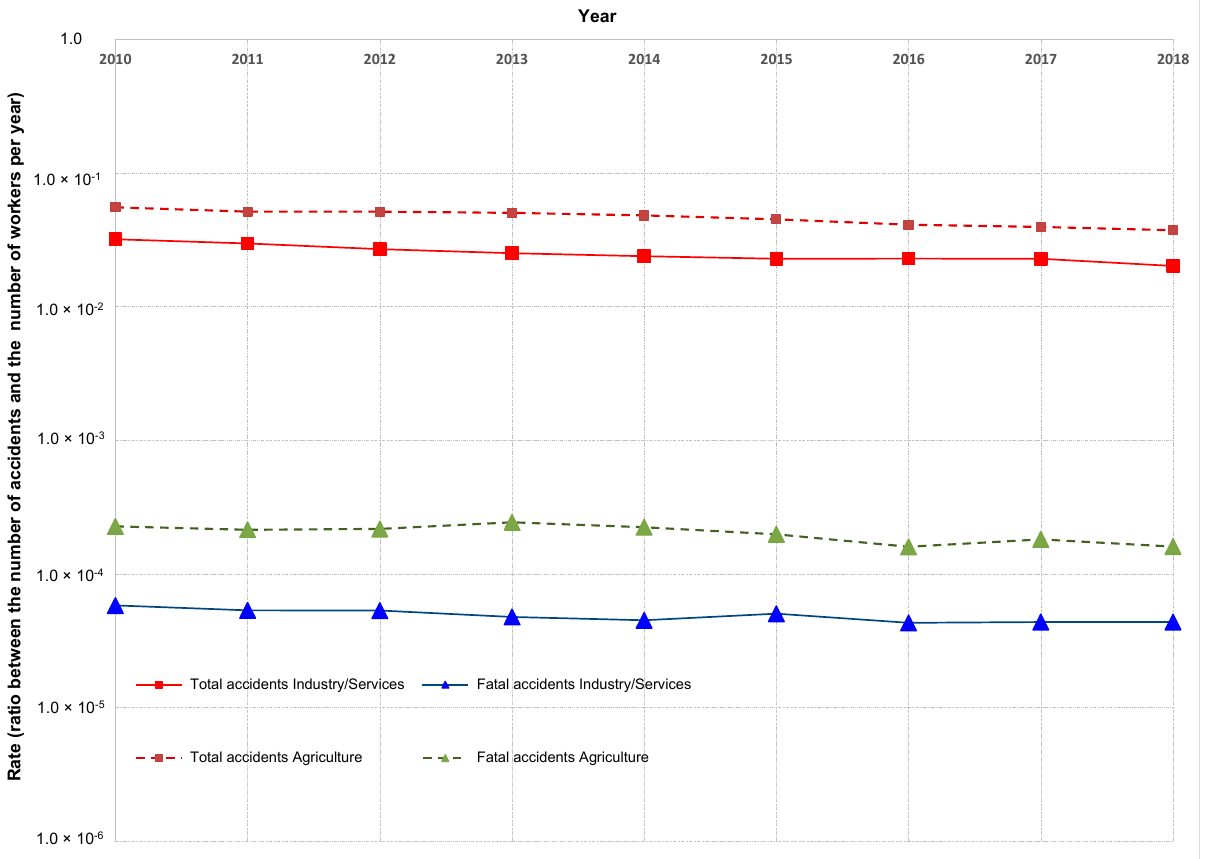
Figure 1. Occupational accidents’ rates in Italy in the period 2010–2018.